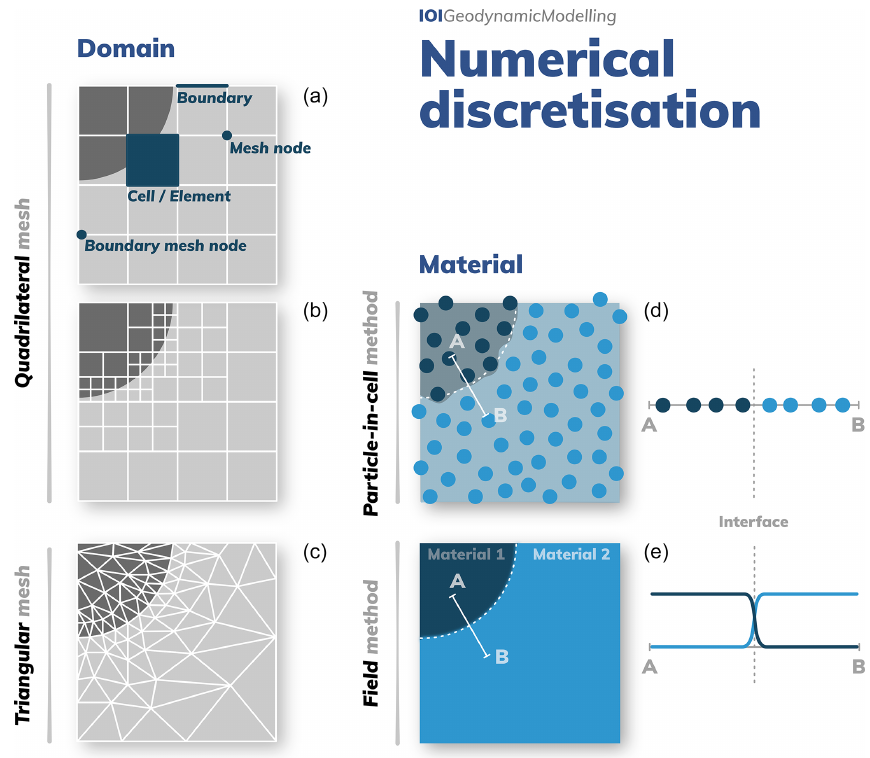
Figure 4. Examples of a two-dimensional domain and material discretisation. The domain discretisation in the left-hand-side column illus- trates different types of meshes. The top left mesh (a) is built on a quadtree and is also shown with several levels of mesh refinement (b) so as to better capture the circular interface. (c) An unstructured triangular mesh built so that element edges are aligned with the (quarter-)circle perimeter. Note that non-rectangle quadrilateral elements can also be used to conform to an interface. The material discretisation is illus- trated by different methods of material tracking in the right-hand-side column based on either the particle-in-cell method (d) or grid-based advection (e) for the material contrasts indicated by the blueish